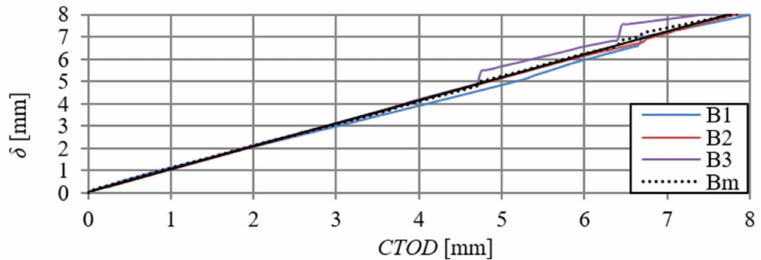
Figure 12. Deflections–crack tip opening displacement relationship of B-series beams and δ –CTOD curve obtained on the basis of the arithmetic mean of results (Bm).